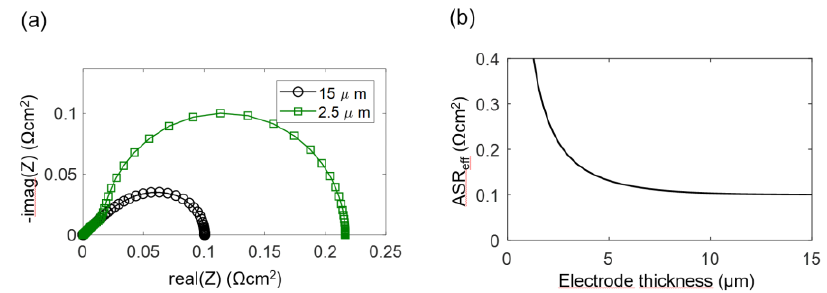
Figure 4. ( a ) Simulated impedance spectra for different electrode thicknesses (15 and 2.5 μm) , with parameter values typical for Ni/GDC at 750 °C. ( b ) Effect of electrode thickness on the polarization resistance ASR eff , according to Equation (32).